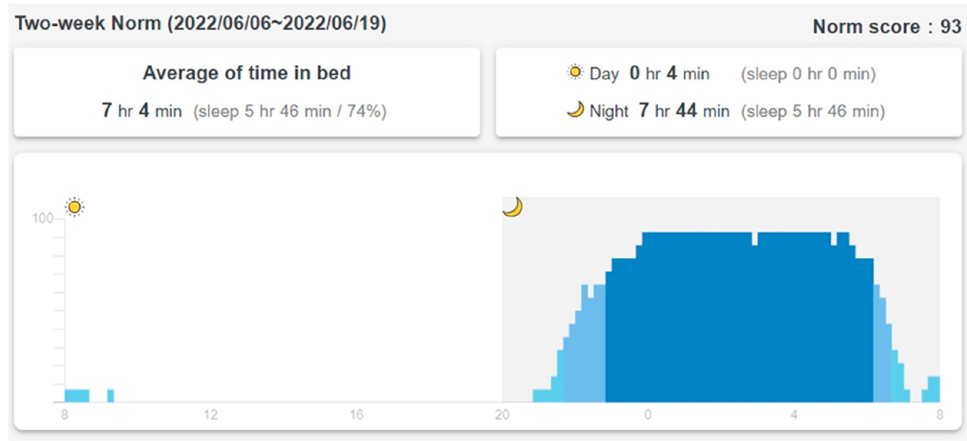
Figure 5. Two-week norm and norm score.